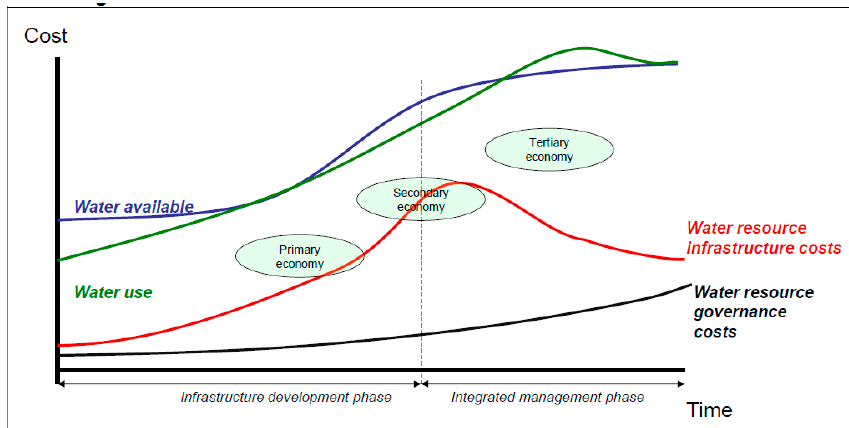
Figure 3. Costs dynamics of water resource governance (black line), water resource infrastructure (red line) and XYZ (green line) as a function of time and related to infrastructure development and implementation of integrated water resource management (graph adapted from EU Water Initiative—Finance Working Group (EUWI-FWG), Report of 2012 on Financing Water Resources Management/Experiences from Sub-Saharan Africa [116]).